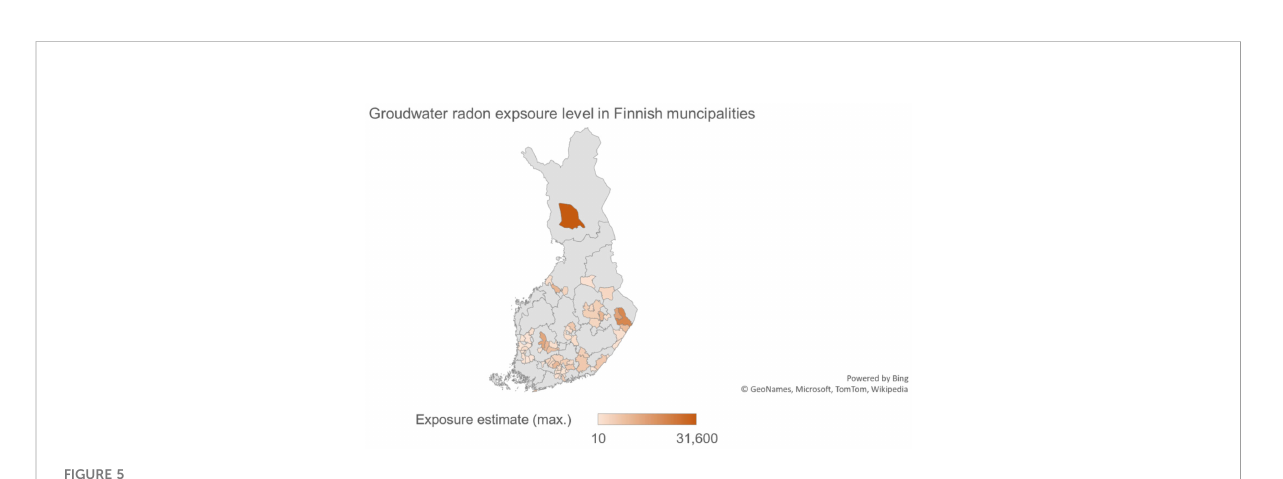
FIGURE 5 Map of Finland indicating radon exposure areas. Source: Senja et al.,